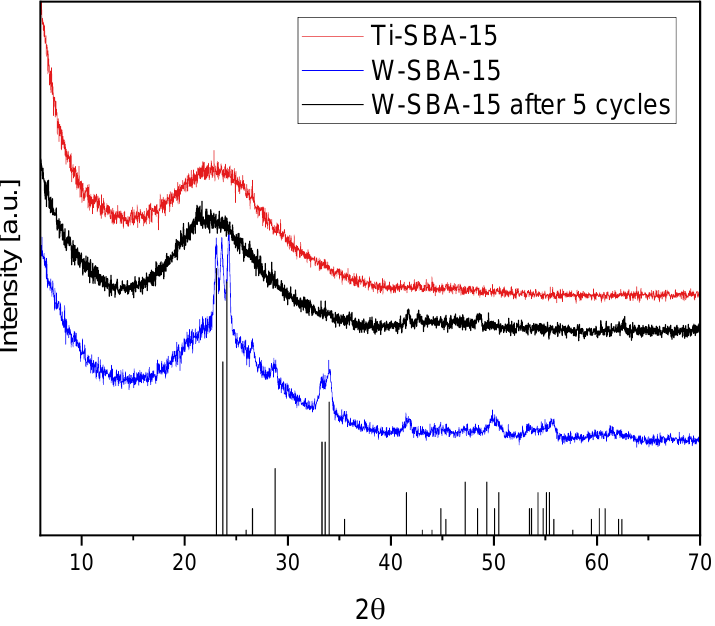
Figure 1. XRD patterns of Ti-SBA-15, W-SBA-15, and W-SBA-15 after 5 cycles. The black bars represent WO 3 diffraction patterns according to the JPCDS card no. 20-1324. Nitrogen sorption isotherms of Ti-SBA-15 and W-SBA-15 are presented in Figure 2. Both isotherms displayed type IV with H1-type hysteresis loops typical of mesoporous materials with one-dimensional cylindrical pores [8]. The position of the hysteresis loop and the sharpness of the adsorption – desorption branches were different. The position where the hysteresis begins is relevant to pore sizes. The hysteresis loop of Ti-SBA-15 was placed in the range of p/p 0 from 0.4 to 0.7. The hysteresis loop of W-SBA-15 was placed in the higher range of p/p 0 from 0.57 to 0.87, and was distinctly sharper. The comparison of isotherm shapes indicated that W-SBA-15 exhibited much wider pores and a higher pore volume than Ti-SBA-15.